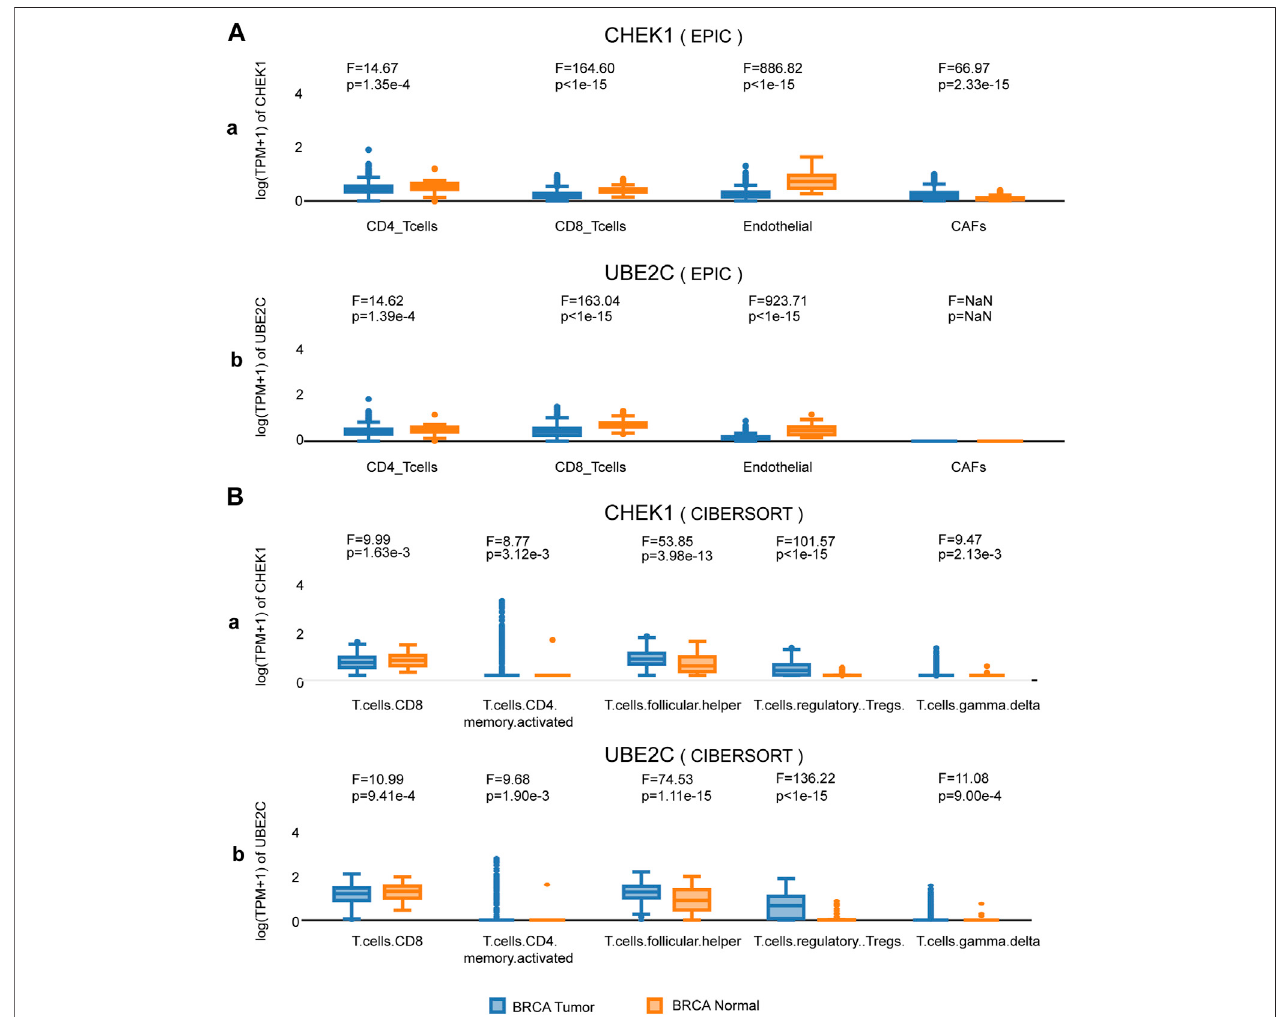
FIGURE 5 | Expression analysis of the two hub genes at cell-type level in BRCA. (A) Expression of the two hub genes in various clusters of human immune cells from BRCA bydeconvolution tool EPIC. (B) Expression of the twohub genesin various clusters ofhuman immune cells from BRCA by deconvolution tool CIBERSORT.